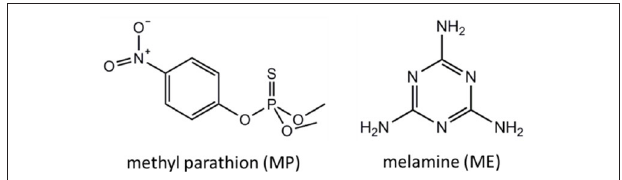
FIGURE 1 | Chemical structures of methyl parathion and melamine,